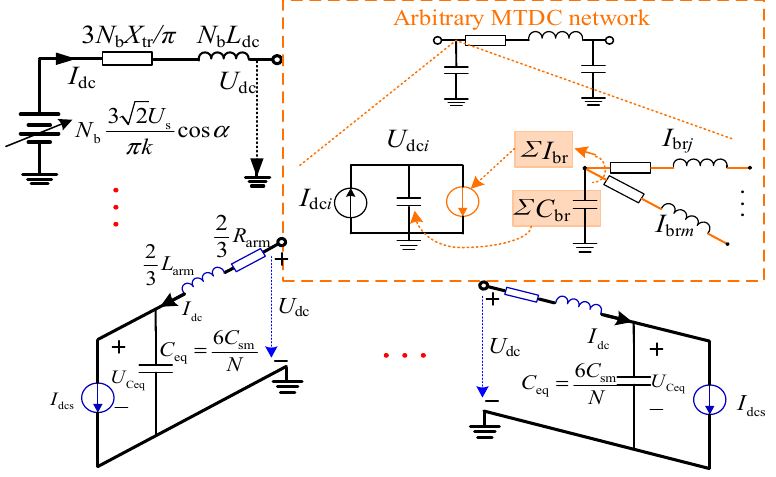
Figure 7. Electromechanical modeling of the hybrid MTDC network.